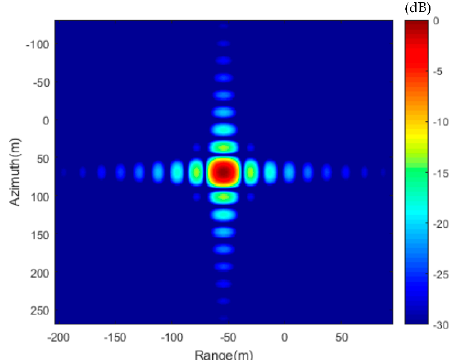
Figure 10. The imaging results with rotational motion matching.